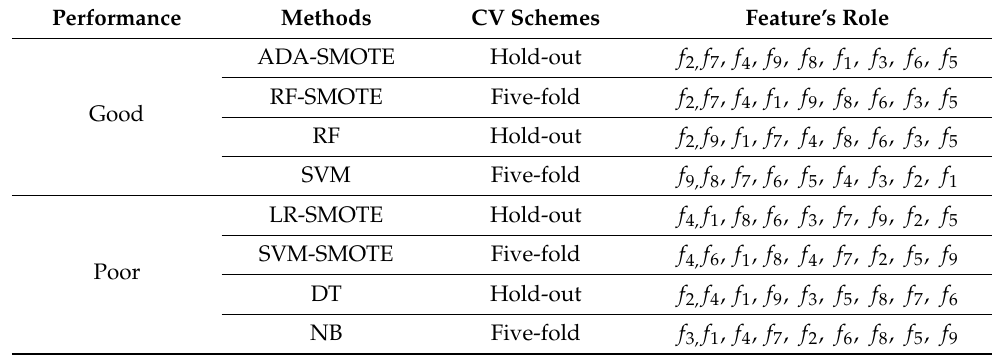
Table 12. Features impact on an AI model’s decision making via